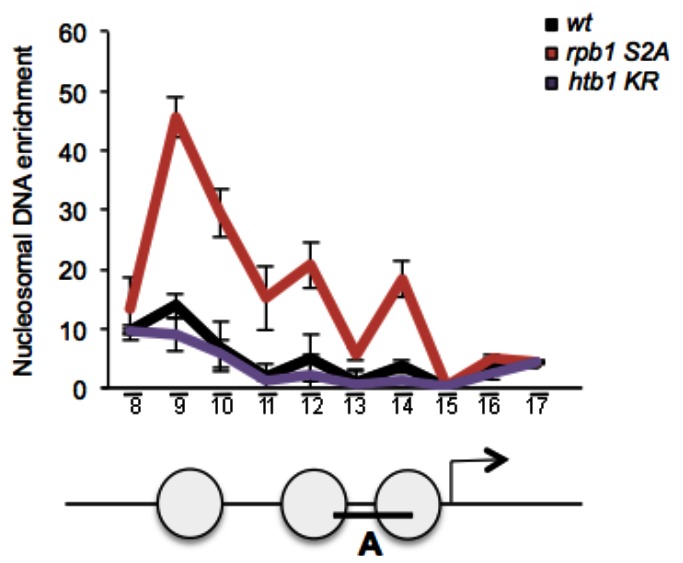
DOI:
http://dx.doi.org/10.7554/eLife.13500.015